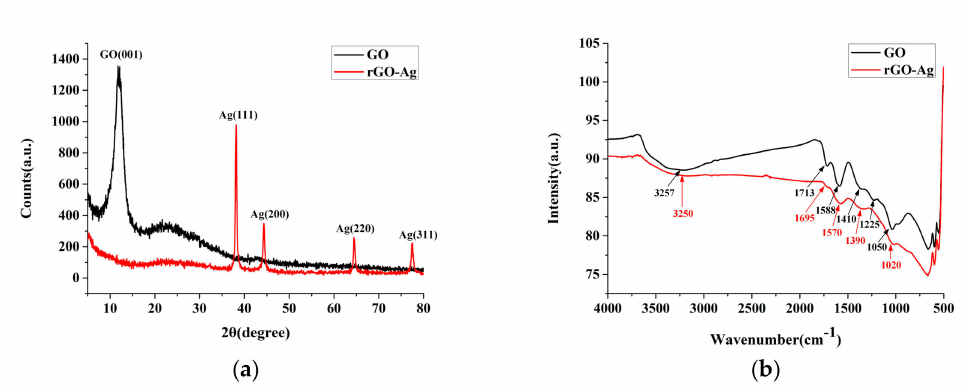
Figure 7. GO and rGOAg: ( a ) X-ray di ff raction (XRD) and ( b ) Fourier-transform infrared spectroscopy (FTIR).